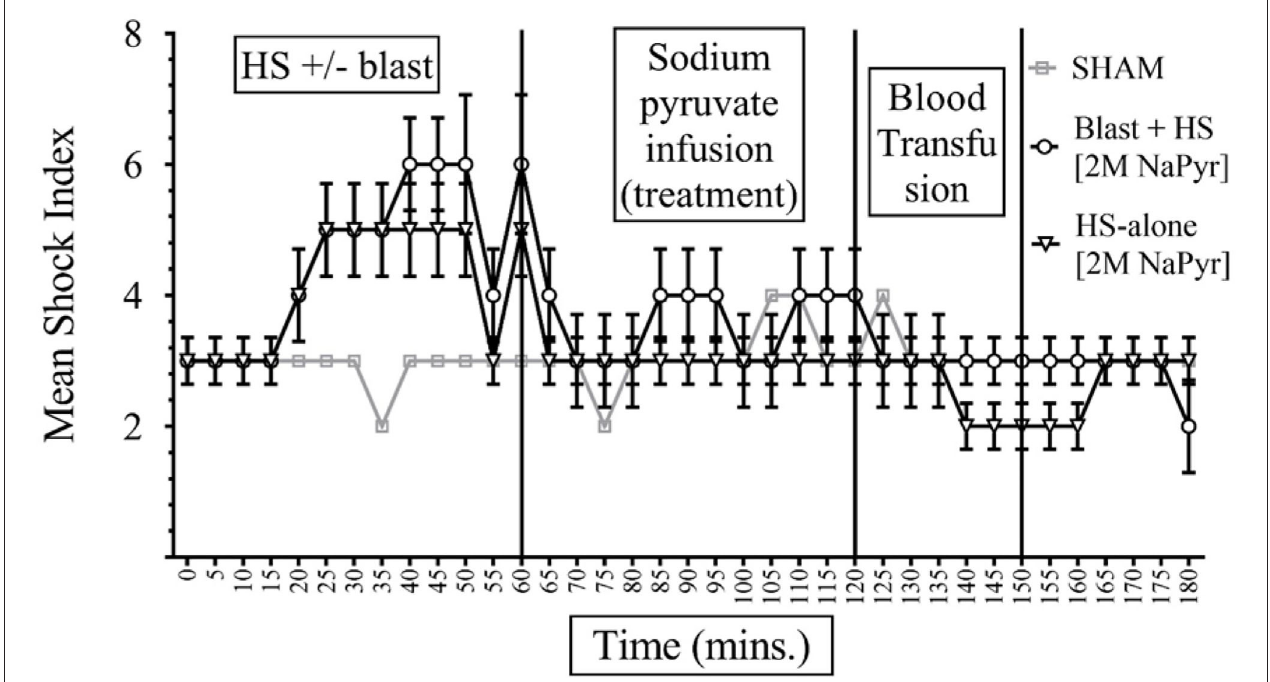
FIGURE 5 | Shock Index (SI) in HS + / − blast injury animals with 2M NaPyr infusion. Results are in Mean ± SE, eight animals per group. SI was higher in the combined injury group in comparison to the HS-alone group after the injury. After the sodium pyruvate resuscitation, SI decreased better near to the baseline value in the HS-alone group in comparison to the combined injury